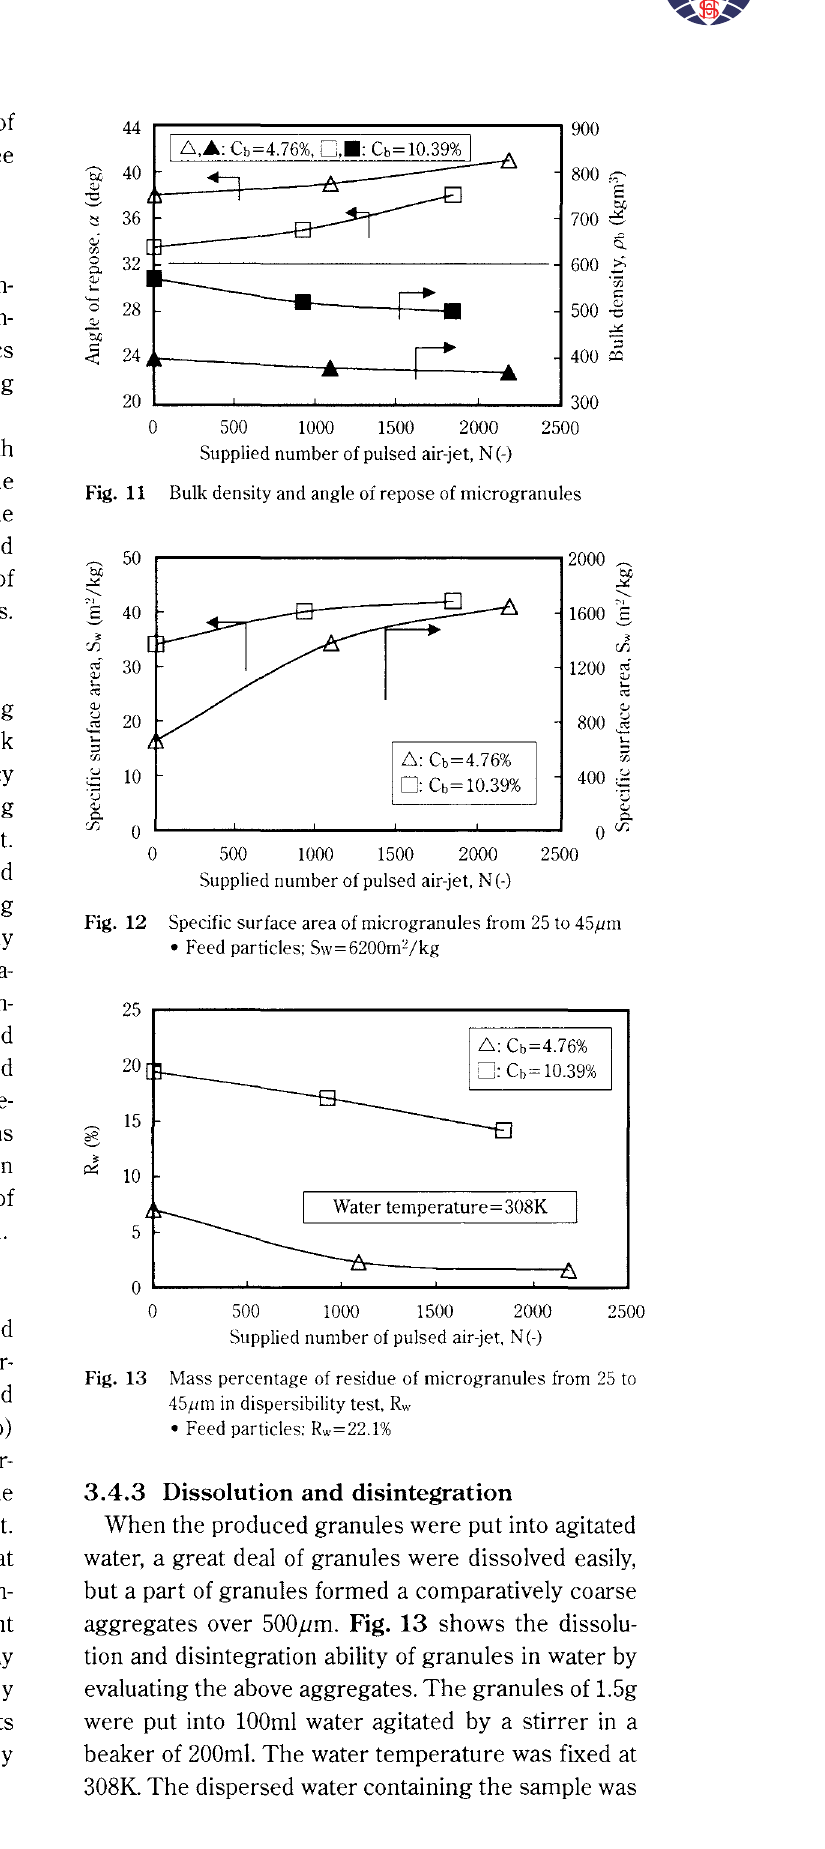
Fig. 11 Bulk density and angle of repose of micro granules